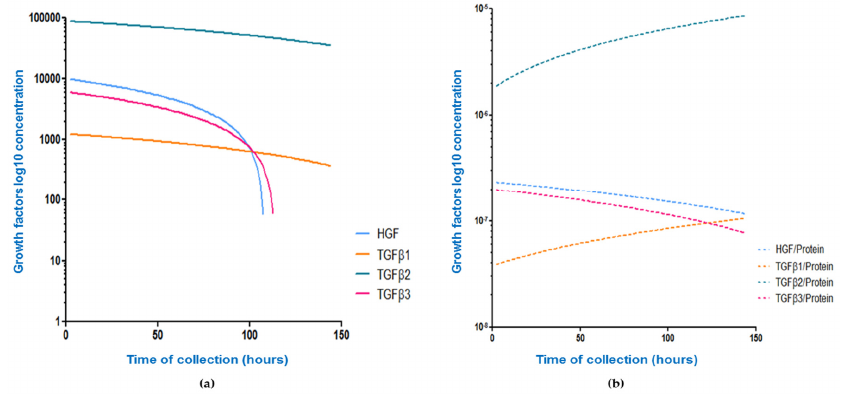
Figure 3. Effect of correcting growth factor concentrations for total protein level on the relationship between concentration and time. Data show nonlinear curves for unadjusted concentrations (pg/mL) of HGF ( blue ), TGF β 1 ( orange ), TGF β 2 ( green ), and TGF β 3 ( pink ) in colostrum in relation to time of sampling. Correlations were explored using raw data ( a ); and the ratio of growth factor concentration to protein concentration in the same sample ( b ). Trends in absolute and relative growth factors concentration in colostrum change over time. All correlation coefficients were statistically significant apart from the TGF β 3/Protein ratio in Figure